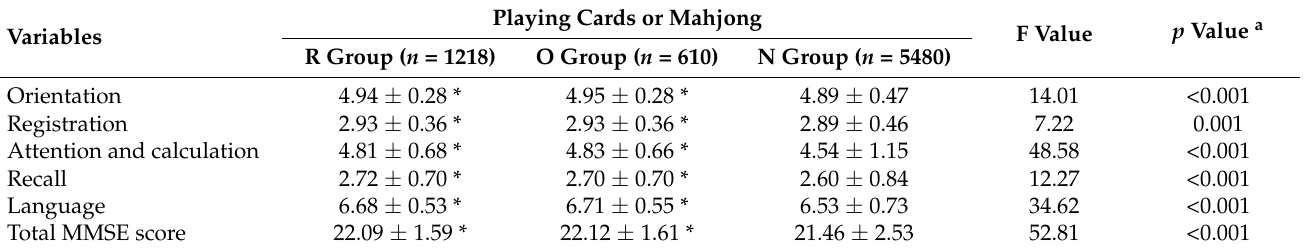
Table 2. The relationship between playing cards or mahjong and MMSE items in 7308 Chinese older adults.